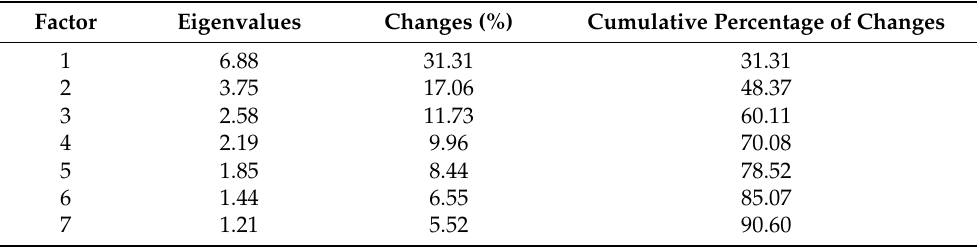
Table 4. Eigenvalues, percentage of changes, and cumulative percentage of variance explained morphological traits of M. aquatica populations from the Hyrcanian hotspot of Iran.